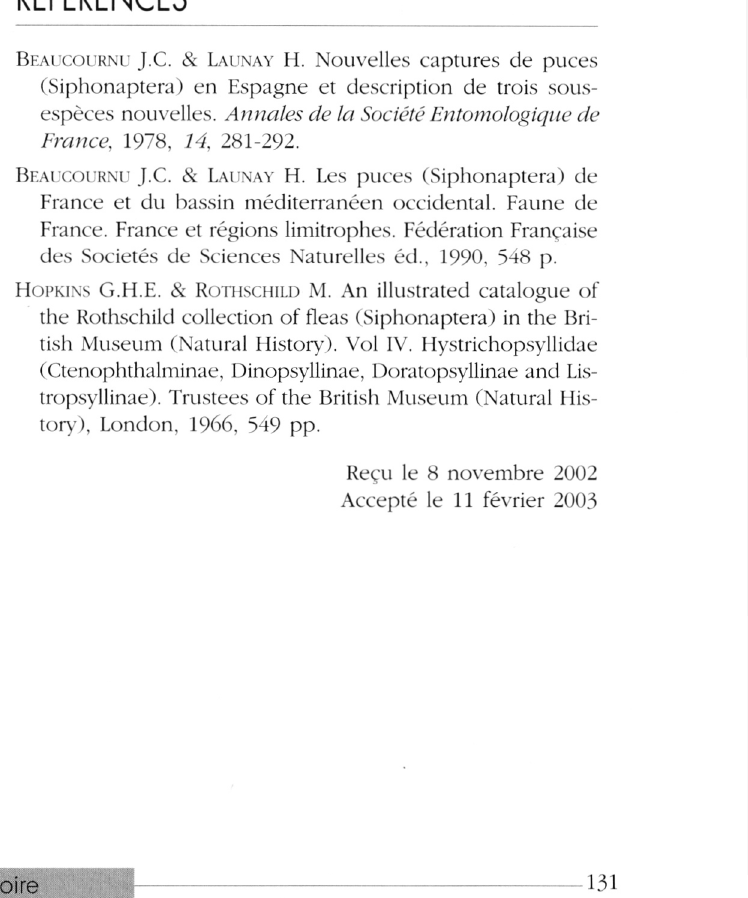
Fig. 4. - Seven different subspecies of Ctenophthalmus (C.) apertus described in